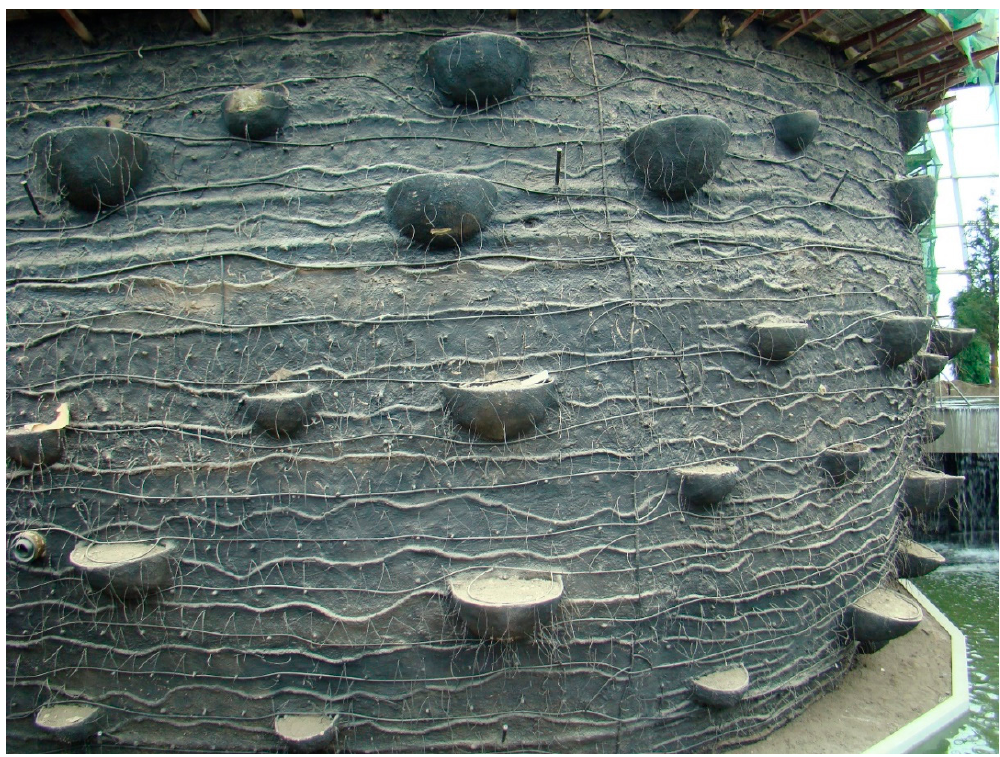
Figure 2. The basic structure of the living wall. The structure is a block building with a mixture of concrete, clay, and organic material (peat) applied as 2 inches of thick slurry over a wire mesh attached to the exterior. The pop-out baskets are designed to provide space for the soil and root.